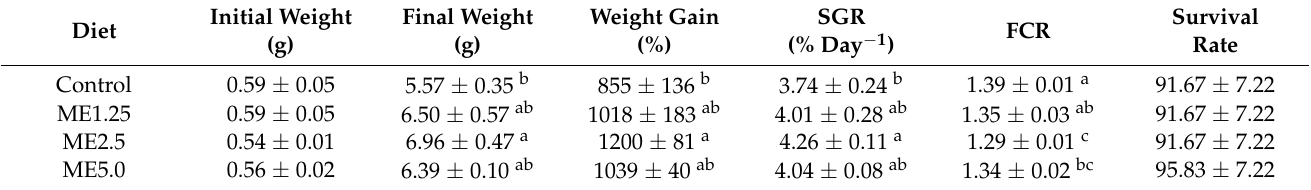
Table 3. The growth performance of whiteleg shrimp fed dietary moringa extracts with different concentrations (control, ME1.25, ME2.5, and ME5.0) for 60 days.